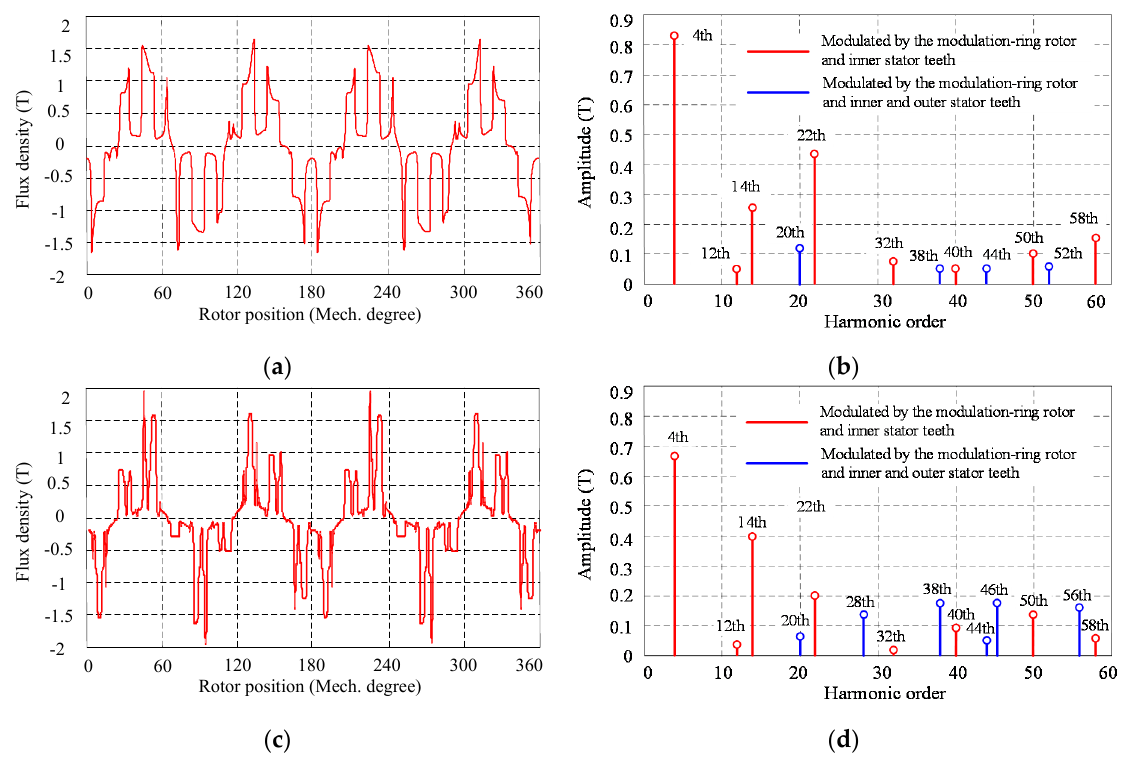
Figure 2. Magnetic flux density with no load: ( a ) Flux density of inner air-gap; ( b ) Harmonic order of flux density of inner air-gap; ( c ) Flux density of outer air-gap; and ( d ) Harmonic order of flux density of outer